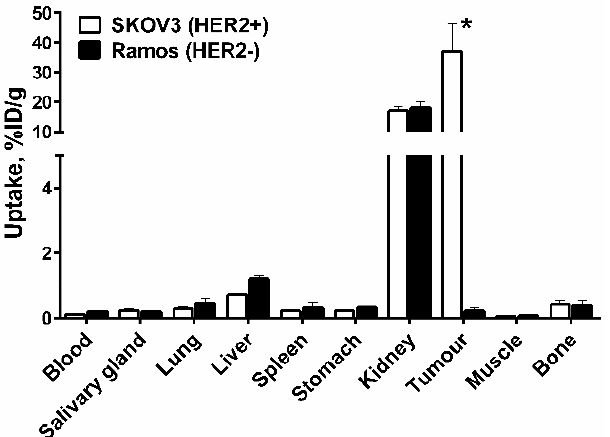
Figure 8. In vivo specificity of [ 99m Tc]Tc-ZHER2:41071 in HER2-negative Ramos xenografts and HER2-positive SKOV3 xenografts at 4 h after injection. The data are presented as the average ( n = 4) and SD. * p <